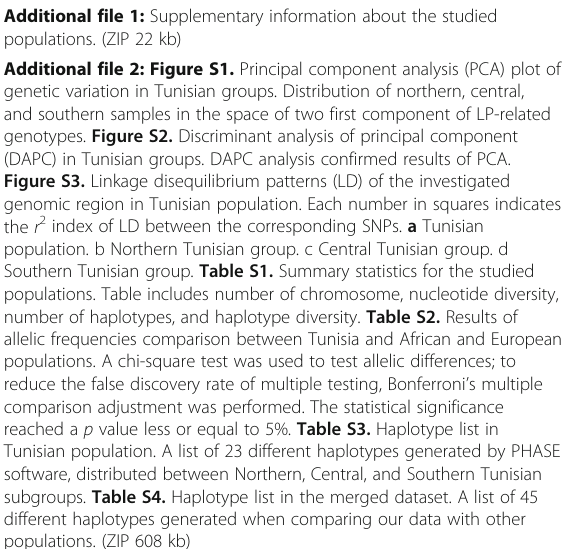
Additional file 2: Figure S1. Principal component analysis (PCA) plot of genetic variation in Tunisian groups. Distribution of northern, central, and southern samples in the space of two first component of LP-related genotypes. Figure S2. Discriminant analysis of principal component (DAPC) in Tunisian groups. DAPC analysis confirmed results of PCA. Figure S3. Linkage disequilibrium patterns (LD) of the investigated genomic region in Tunisian population. Each number in squares indicates the r 2 index of LD between the corresponding SNPs. a Tunisian population. b Northern Tunisian group. c Central Tunisian group. d Southern Tunisian group. Table S1. Summary statistics for the studied populations. Table includes number of chromosome, nucleotide diversity, number of haplotypes, and haplotype diversity. Table S2. Results of allelic frequencies comparison between Tunisia and African and European populations. A chi-square test was used to test allelic differences; to reduce the false discovery rate of multiple testing, Bonferroni ’ s multiple comparison adjustment was performed. The statistical significance reached a p value less or equal to 5%. Table S3. Haplotype list in Tunisian population. A list of 23 different haplotypes generated by PHASE software, distributed between Northern, Central, and Southern Tunisian subgroups. Table S4. Haplotype list in the merged dataset. A list of 45 different haplotypes generated when comparing our data with other populations. (ZIP 608